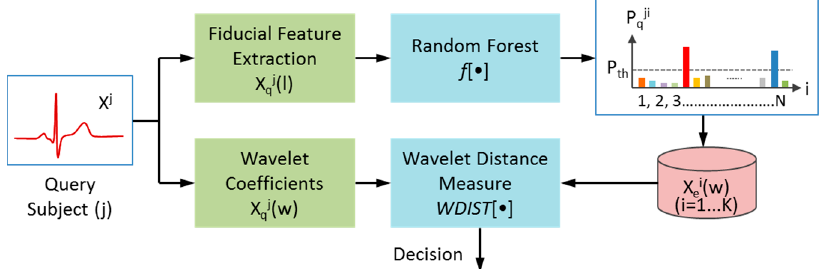
Figure 3. Proposed two-stage ECG biometric subject verification algorithm. The fiducial feature X j q ( l ) is first applied to the random forest classifier, to identify the limited K potential candidates (usually K < 5). Next, the non-fiducial feature X j q ( w ) (wavelet coefficient) is applied to a 1-to- K template matching classifier to make the final decision.